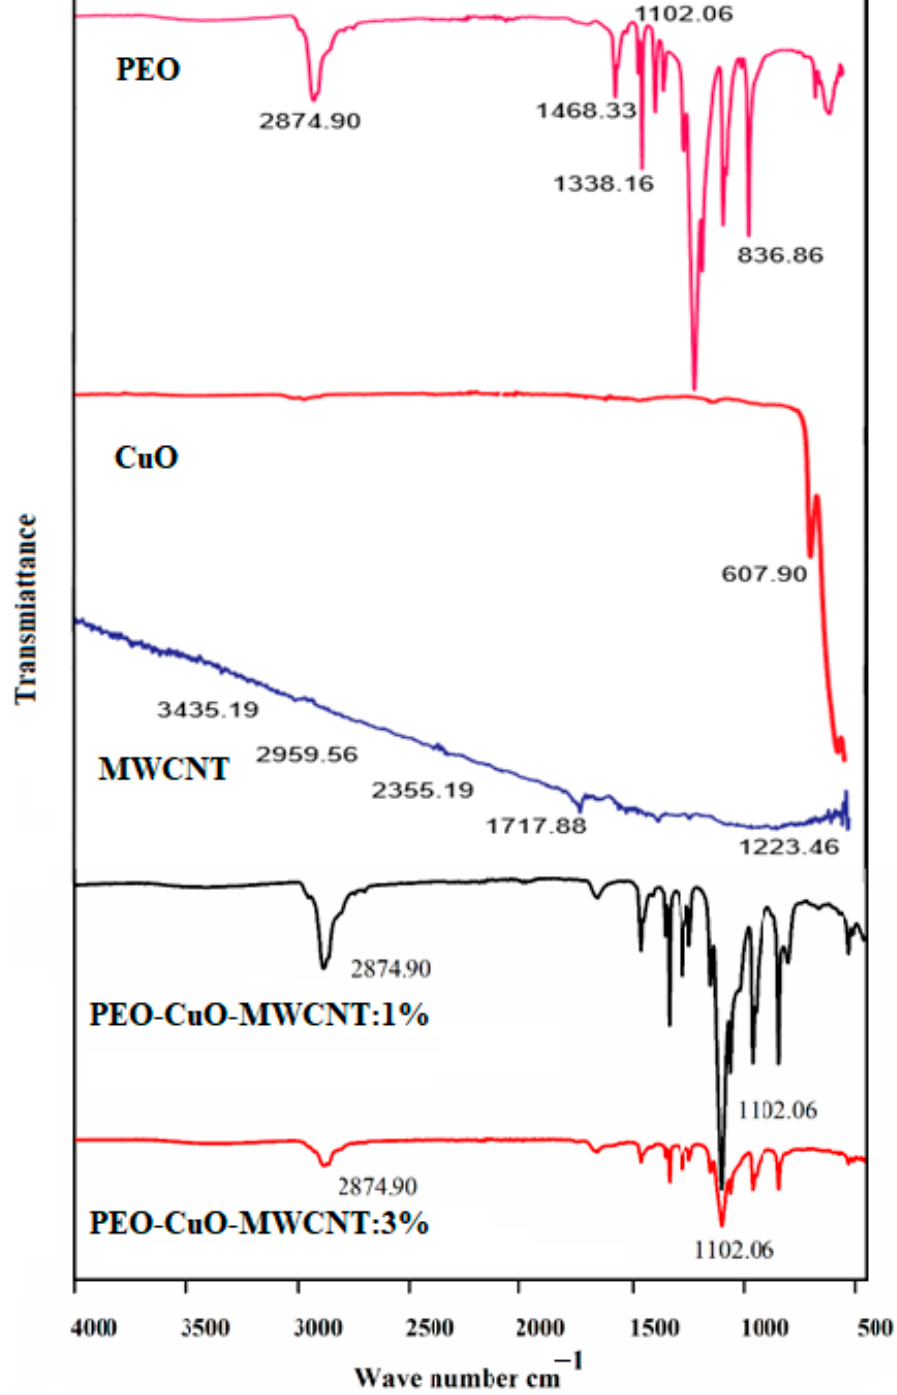
Figure 2. FTIR spectra of pure PEO (purple), CuO nanoparticles (red) and MWCNTs (blue), PEO– CuO–MWCNT: 1% (black) and PEO–CuO–MWCNT: 3% (orange) composite